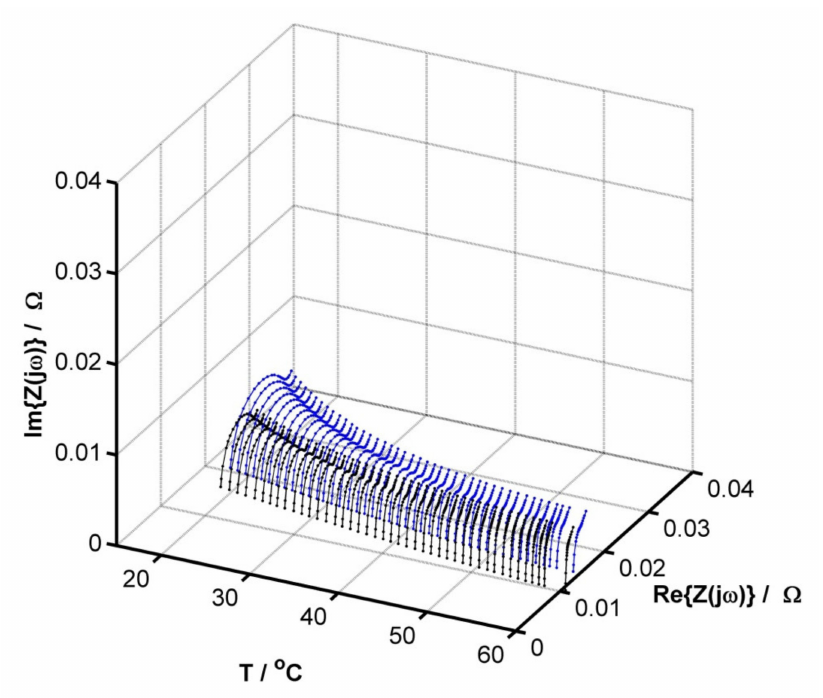
Figure 5. Comparison of impedance graphs for SoC equal to 0% (blue line) and 100% (black line) in the temperature range from 15 to 60 degrees Celsius.